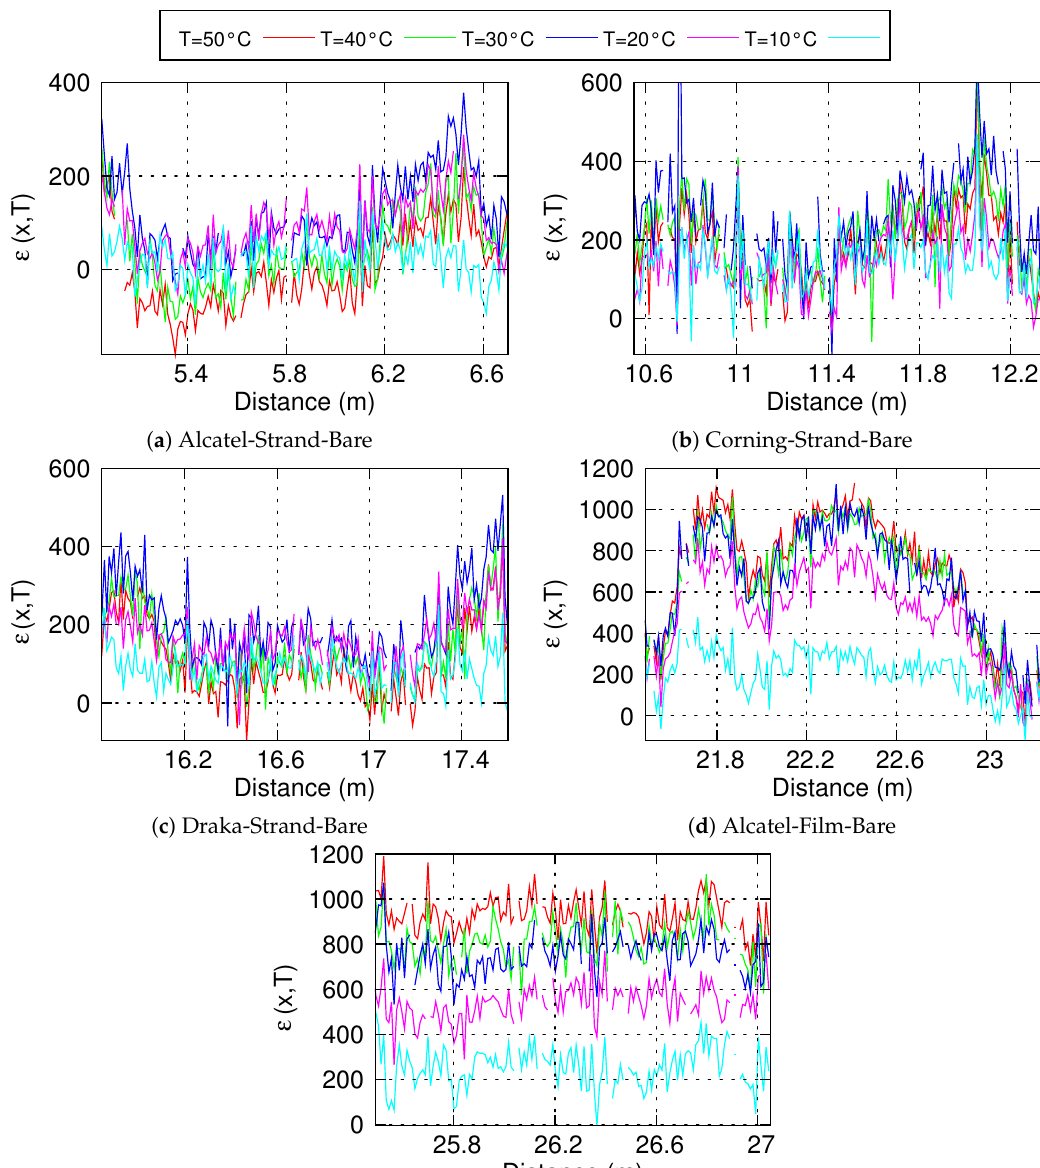
Figure 10. Strap induced strain for the different samples and different temperatures ( a – e